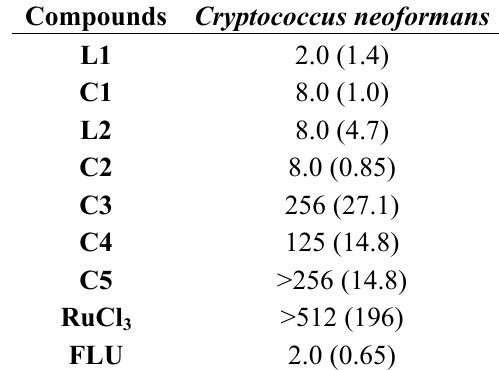
Table 7. In vitro cytotoxicity of the studied pentakis-dithiocarbamate diruthenium complexes under normal cell line BHK (IC